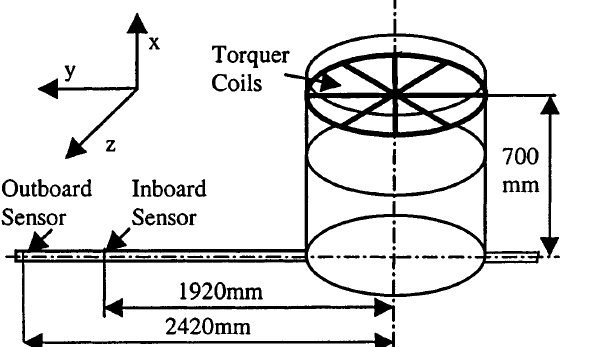
Fig. 3. Accommodation of magnetometer sensors and torquer coils